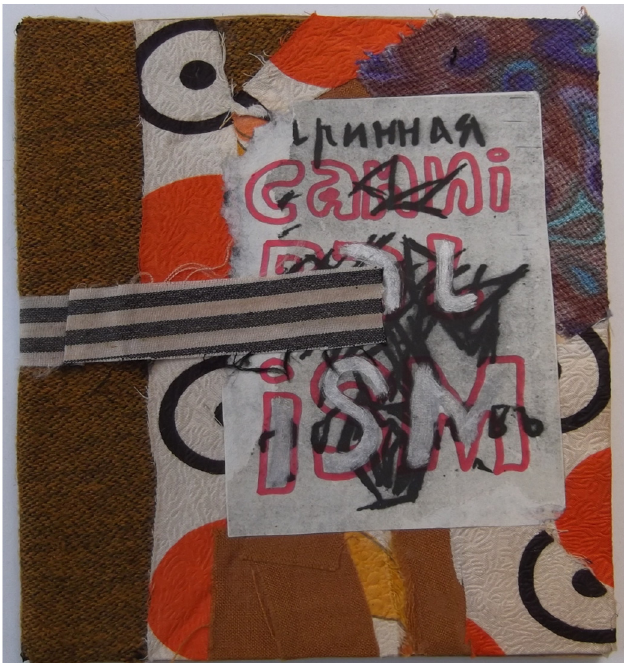
Figure 19. Fourth booklet.